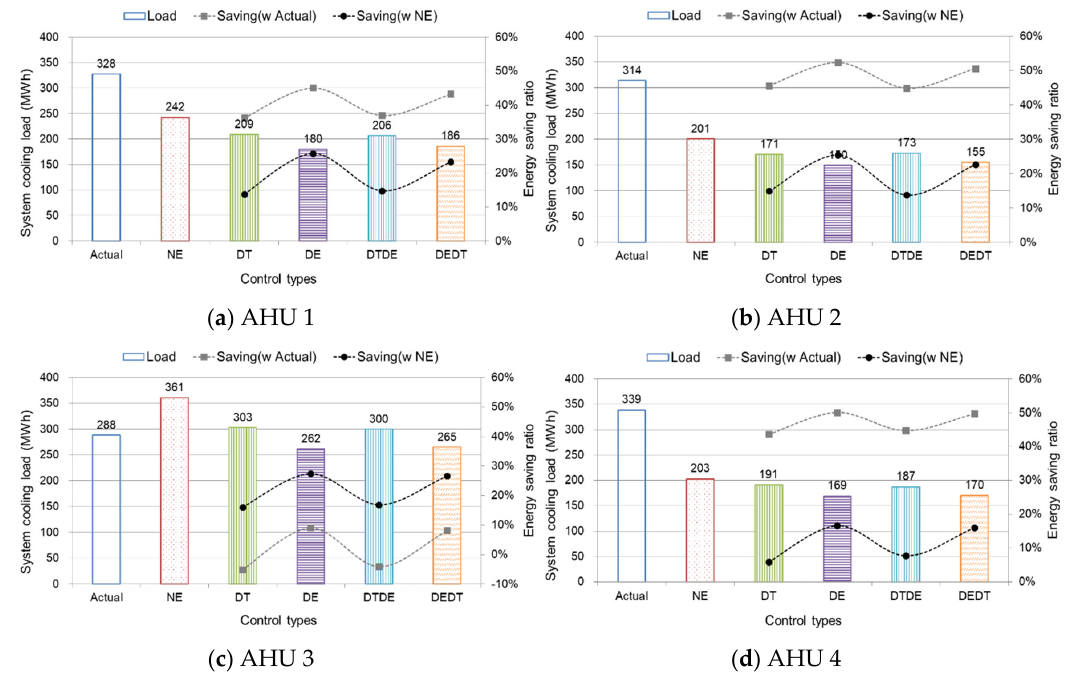
Figure 11. System cooling loads of the AHUs by control types and energy-saving ratio.